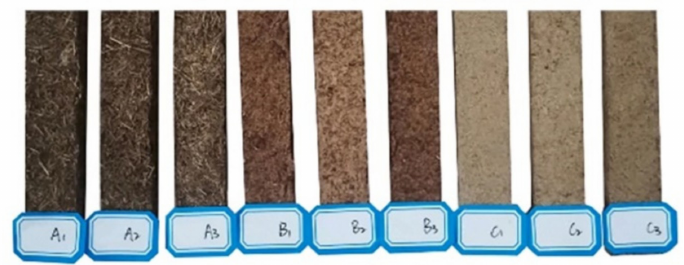
Figure 11. Straw fiber test